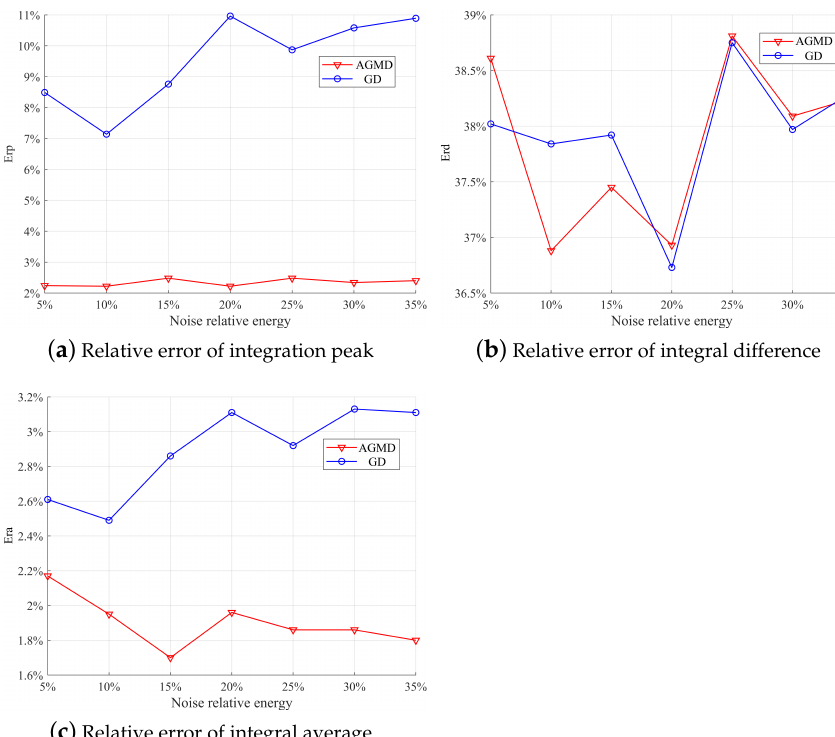
Figure 10. Error of each algorithm under different noise relative energy.